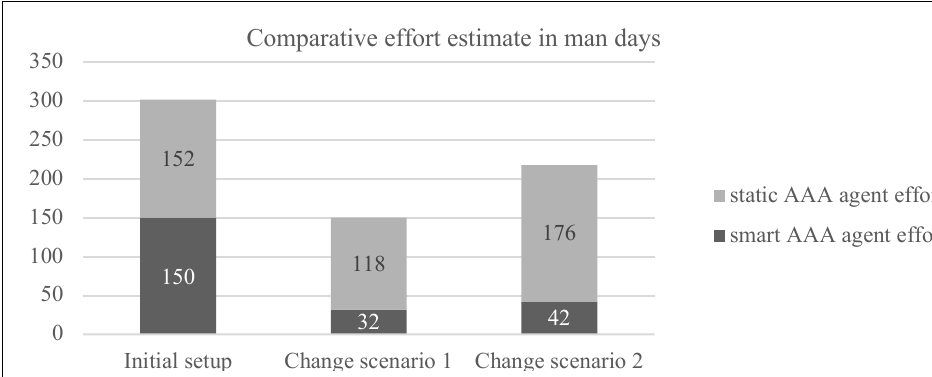
Figure 6. Smart AAA agent vs static AAA agent usability effort